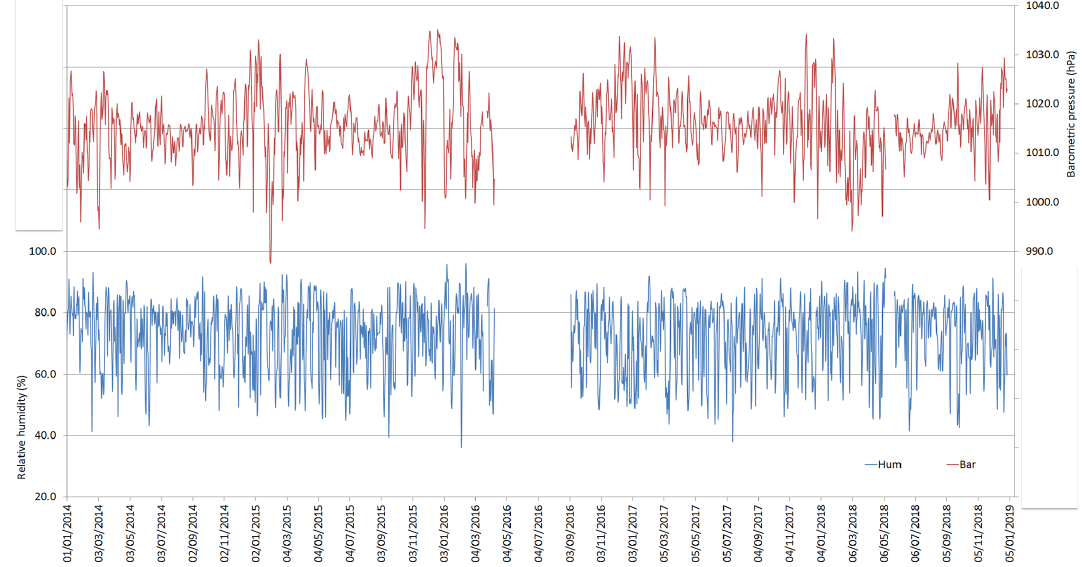
Figure 20. Barometric pressure and humidity time series data showing seasonal and annual variation patterns at the Denza station during